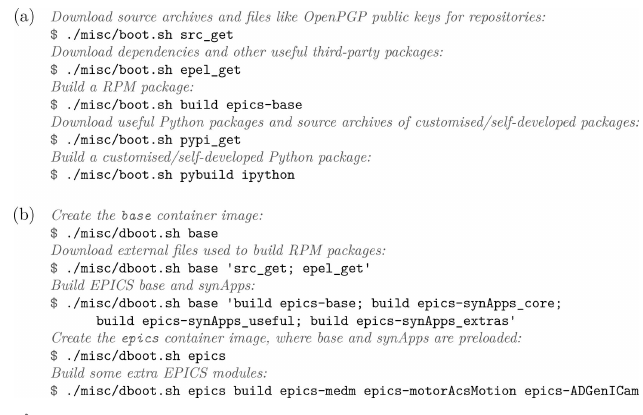
Figure 3 Example usage of ( a ) boot : sh and ( b ) dboot : sh , both expected to be executed from the root directory of the build